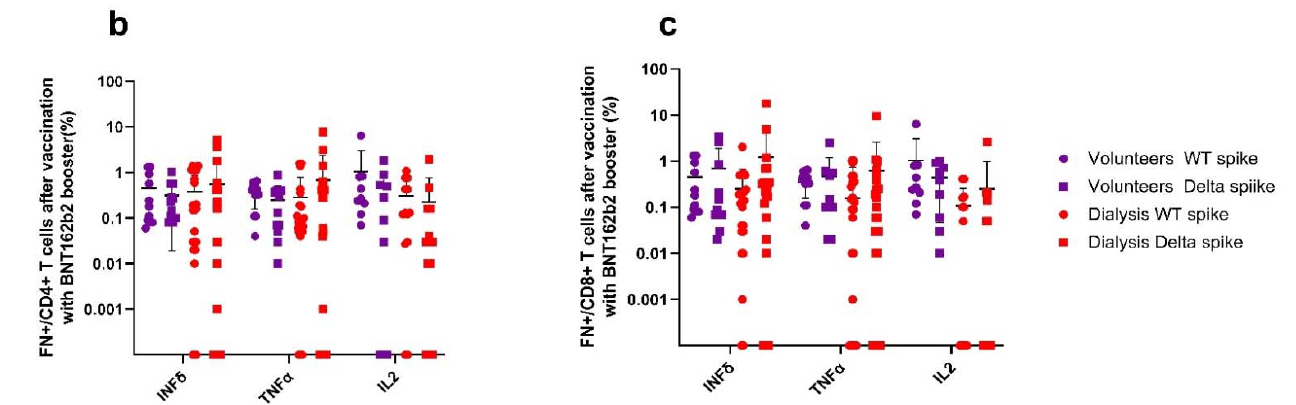
Figure 3. Cellular immune response to wild ‐ type (WT) spike and Delta spike. Spike peptide ‐ specific responses by intracellular cytokine staining assays in CD8+ T cells and CD4+ T cells ( a – c ) 4 months after vaccination in dialysis patients ( ● ■ ) or volunteers ( ● ■ ). Means of CD4 or CD8 % population presenting a response ( b , c ) are numerically shown. CD4+ ( b ) CD8+ T cells’ ( c ) production of IL2, TNF α and IFN γ against WT spike ●● and B.1.617.2 (Delta) ■■ . Media backgrounds were subtracted from the specific values. Representative dot blot FACS analysis ( a ). CD4+ or CD8+ T cells’ response to spike stimulation in PBMCs from dialysis patients compared to the healthy cohort. Additionally, shown are cellular response data from unvaccinated, uninfected individuals, or after infection (convalescent).